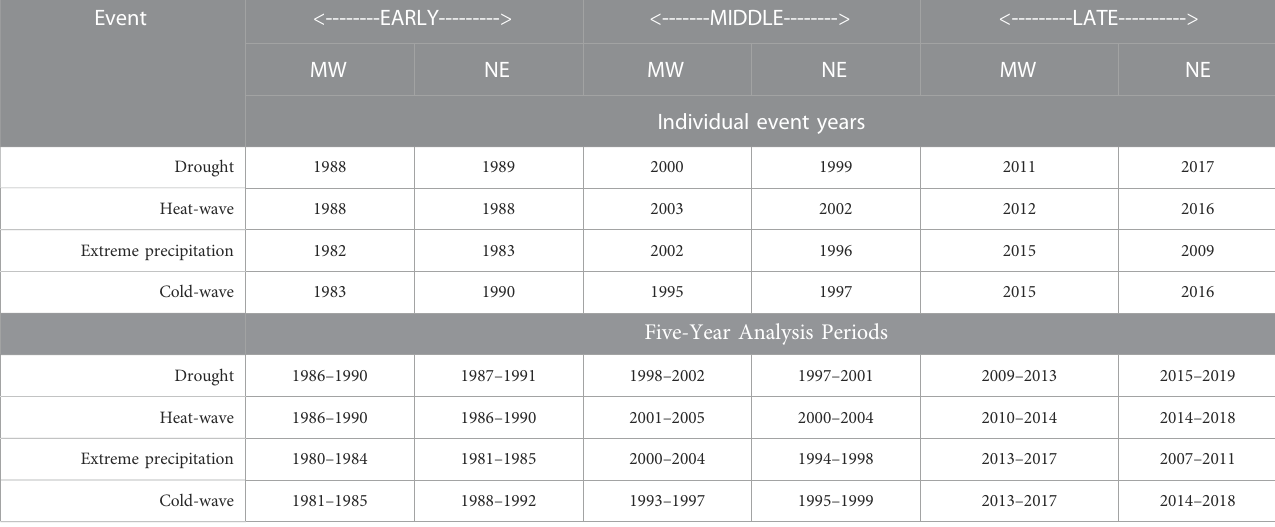
TABLE 1 Target years and associated 5-year analysis periods (2 years pre/post) in the historical record for the US Midwest and Northeast during the early, middle, and late stages of the historical time period. Individual years representing speci fi c extreme events* are identi fi ed using the methods summarized in the narrative. Individual yearscanbeassociatedwithmultiple categoriesofeventsrecorded(e.g.,extremeprecipitationandcold-wavesacross theMWin2015;cold-wave andheat- wave in the NE in 2016). Adapted from (Sanyal and Wuebbles, 2022a; Sanyal and Wuebbles,